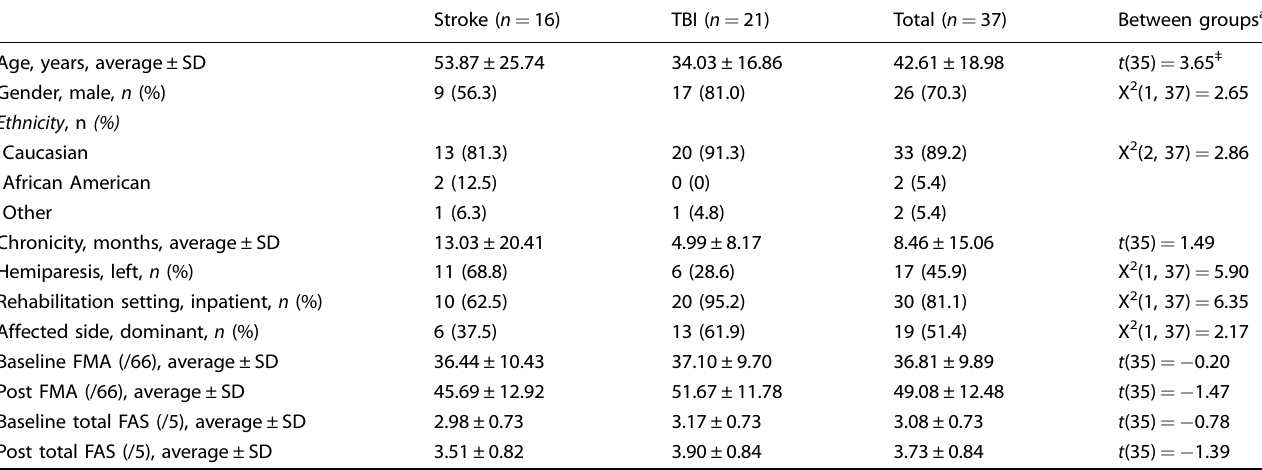
Table 1. Comparison of subjects ’ clinical characteristics (stroke and